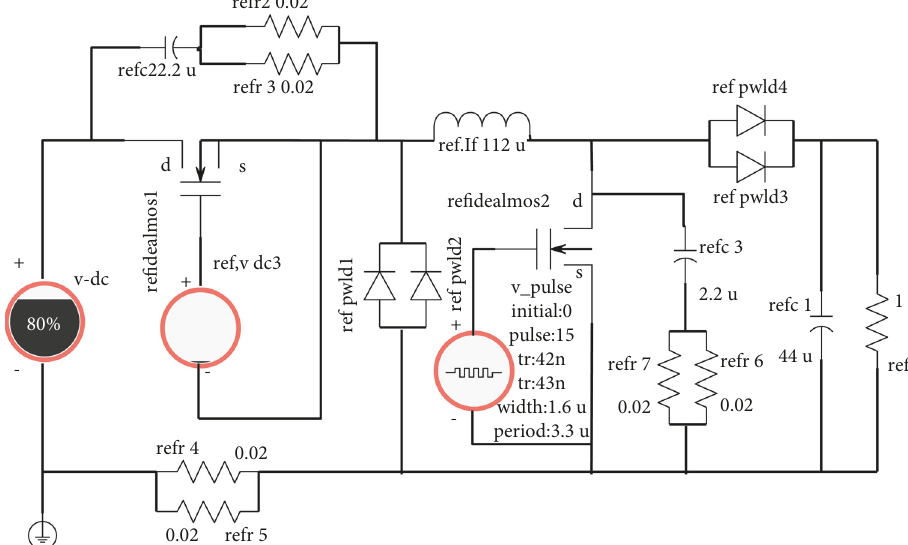
Figure 4: Circuit simulation diagram of the main circuit of double-tube buck-boost power conversion in boost mode.